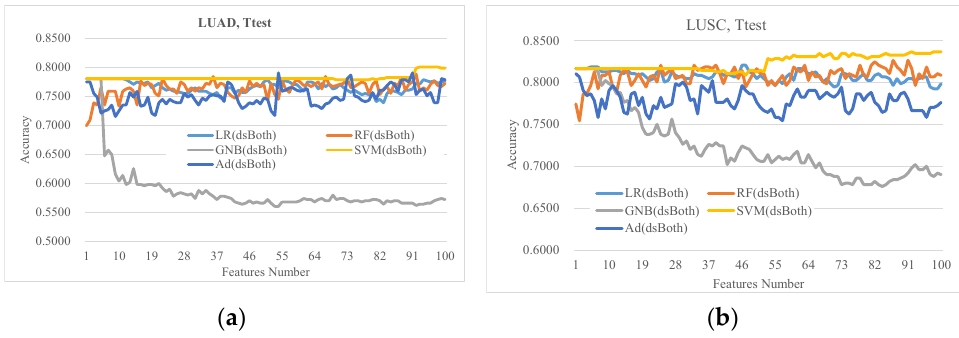
Figure 2. Classification performances of the top-ranked 100 features by Ttest. The classification accuracy was calculated by the 10-fold cross validation strategy for the five classifiers, i.e., LR, SVM, RF, GNB, Ad. The horizontal axis is the number of the top-ranked features used in each calculation and the vertical axis is the classification accuracy. The experimental data were visualized ( a ) on the LUAD, and ( b ) on the LUSC.